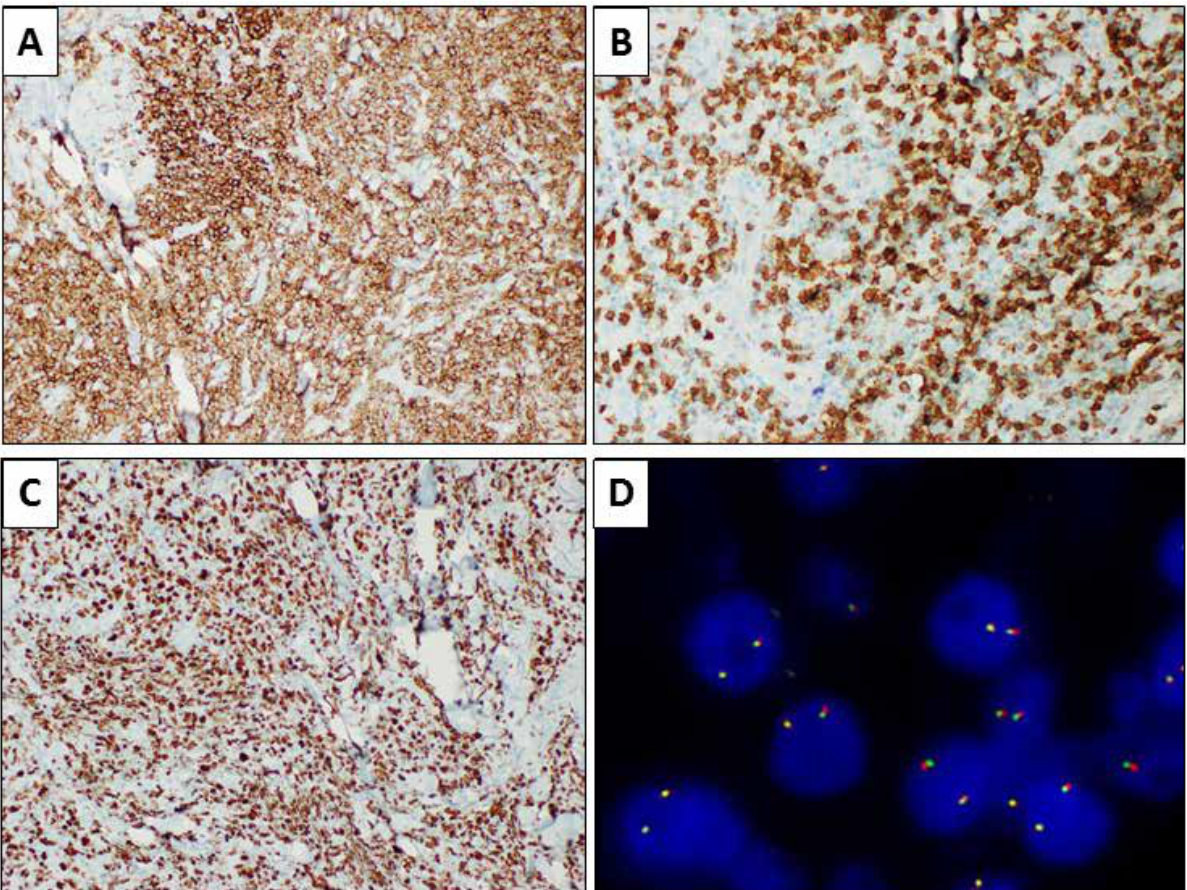
Figure 3: Immunohistochemical evaluations showing positivity for CD20 (A, immunohistochemical staining, 10x) and negativity for CD3, which was negative in the large neoplastic cells but resulted positive in the T-cell population in the background (B, immunohistochemical staining, 20x). Results for Ki67 were positive in about 90% of the cells (C, immunohistochemical staining, 10x). Fluorescence in-situ hybridi- zation showing wild-type MYC gene (D, break-apart probe